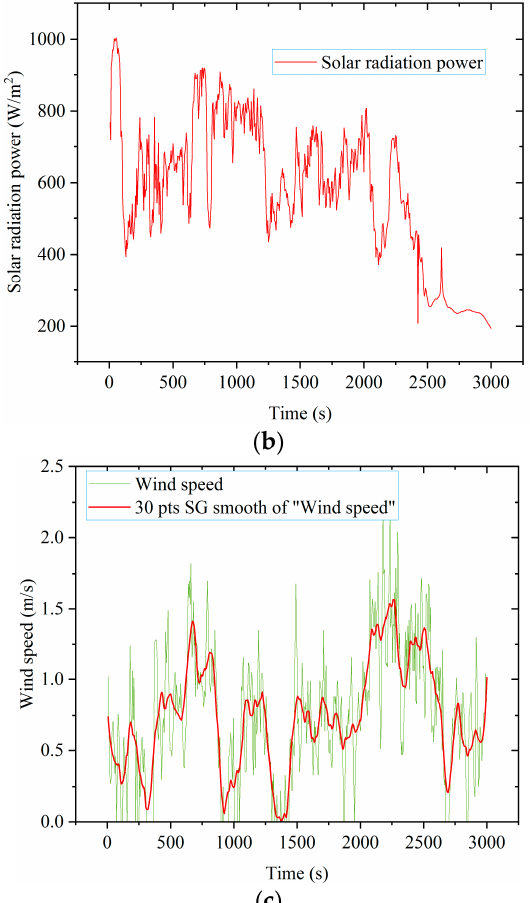
Figure 9. Photovoltaic panel surface temperature and environmental conditions: ( a ) temperature of photovoltaic panel and ambient; ( b ) solar radiation power; ( c ) wind speed.